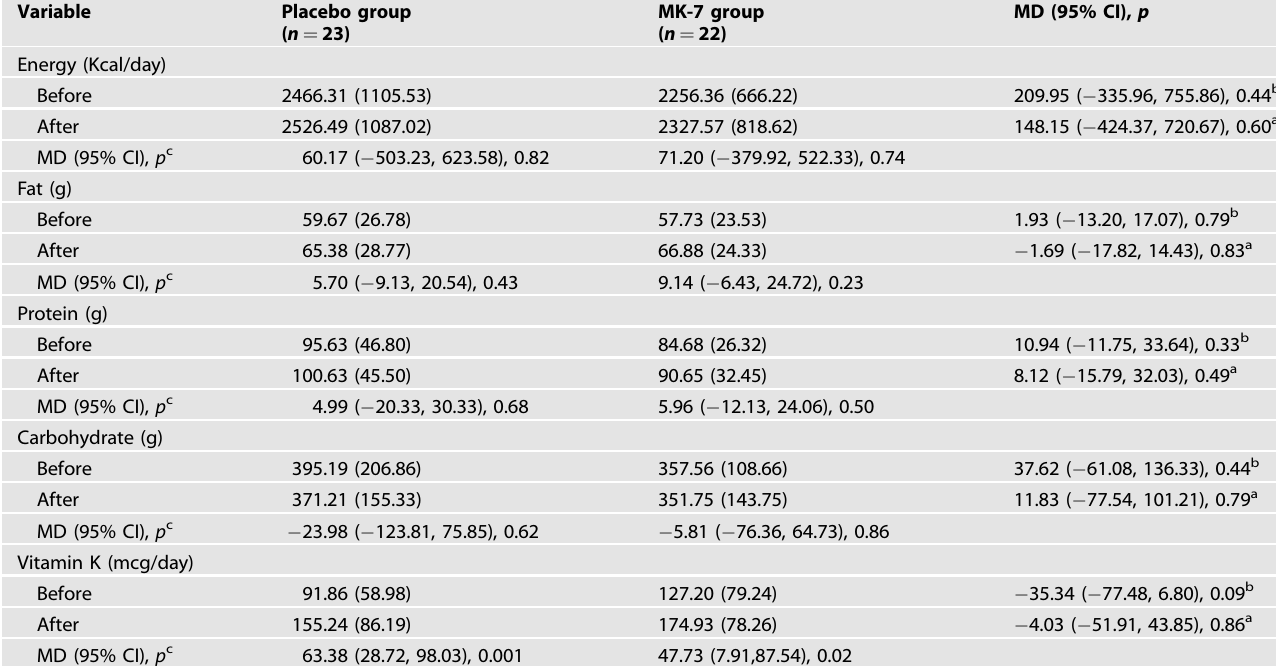
Table 2. Comparison of the dietary intake between study groups at baseline and the end of the